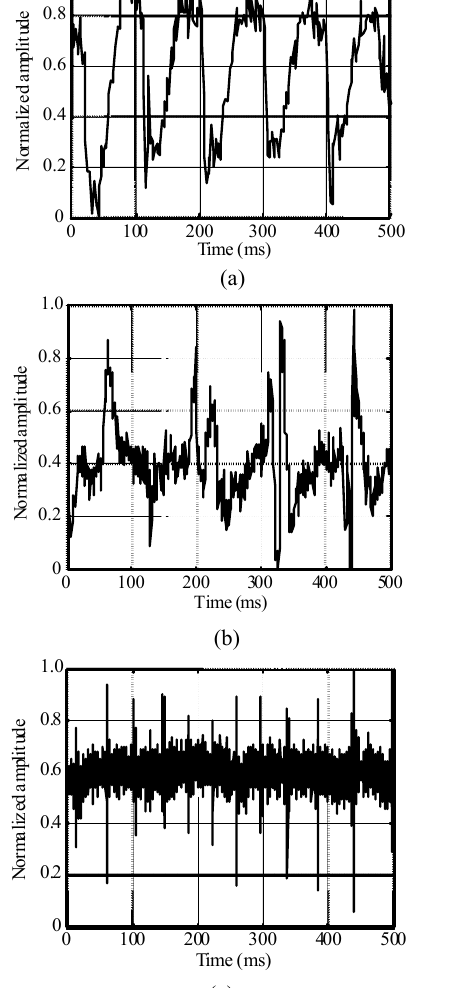
Fig. 6 Result of multi-level wavelet decomposition: (a) running signals, (b) digging signals, and (c) pick mattock